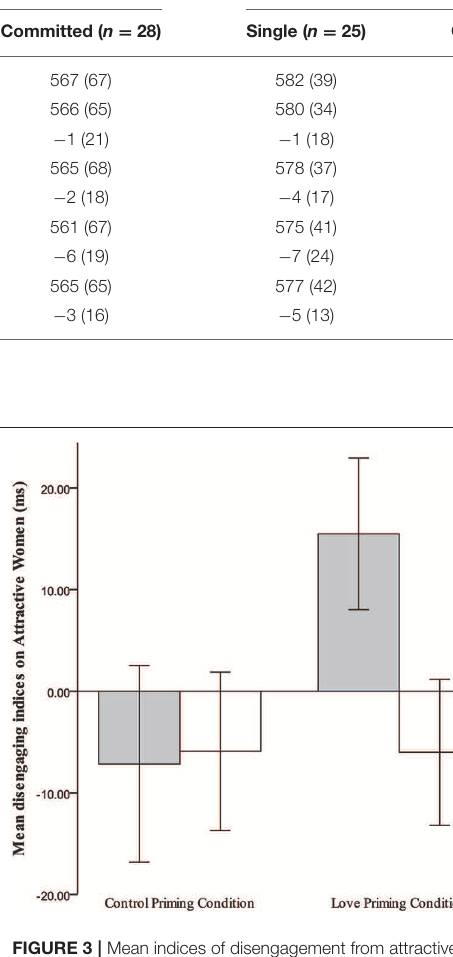
Frontiers in Psychology |